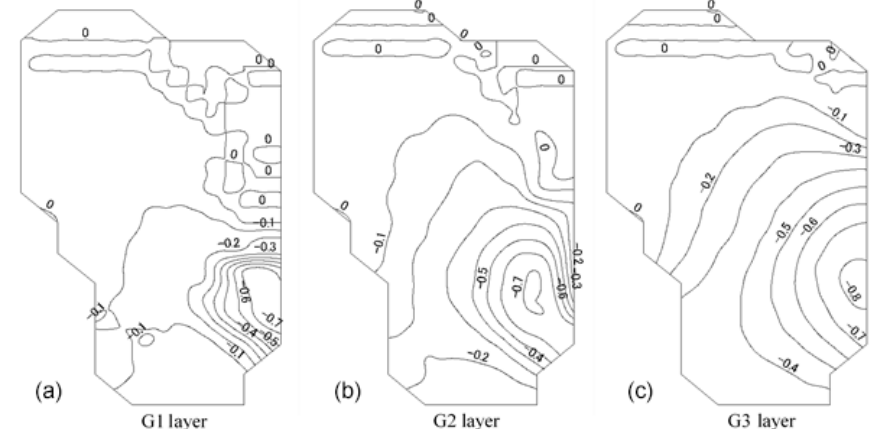
Figure 3. Groundwater level differences following well operation (Case 2) (m).